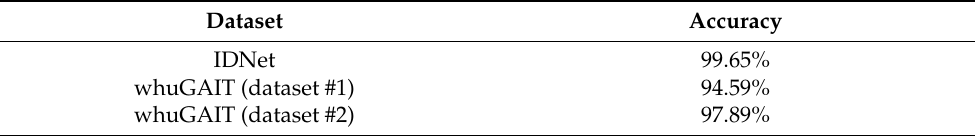
Table 4. The robustness of HDLN on different